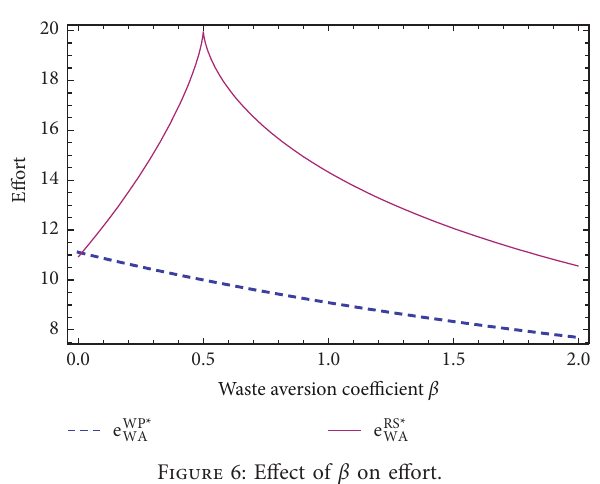
Figure 6: Effect of β on effort.